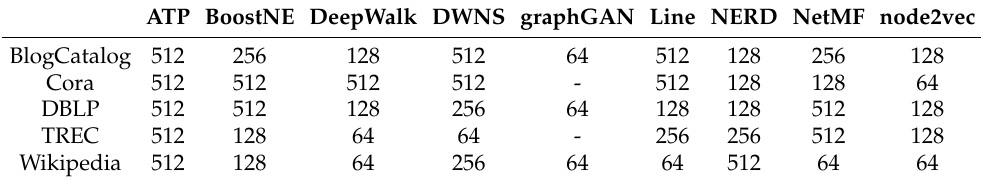
Figure 5. Accuracy of embedding methods with TREC and Wikipedia datasets for different values of d . Table 3. Best values of d for all embedding